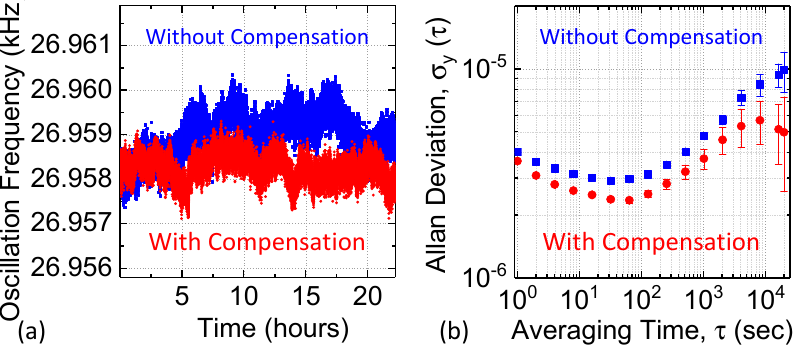
Figure 9. ( a ) Instantaneous frequency of the uncompensated and compensated oscillators over 24 h; ( b ) Measured Allan deviation σ A ( τ ) with and without real-time temperature compensation.